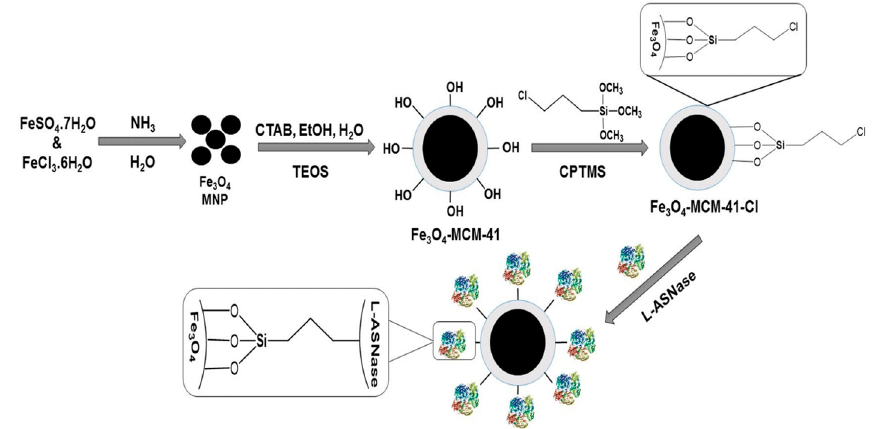
Figure 68. Schematic illustrates stapes of magnetic Fe 3 O 4 @MCM-41-Cl nanoparticle preparation, modification, and the immobilization of L-ASNase. Reproduced with permission from [174]. Copyright 2018 Springer.